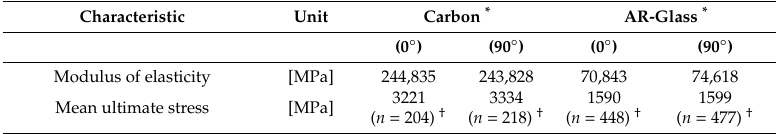
Table 1. Reinforcement characteristics for impregnated planar carbon and alkali resistant (AR)-glass grid (properties of one individual yarn, from [34] with test setup according to